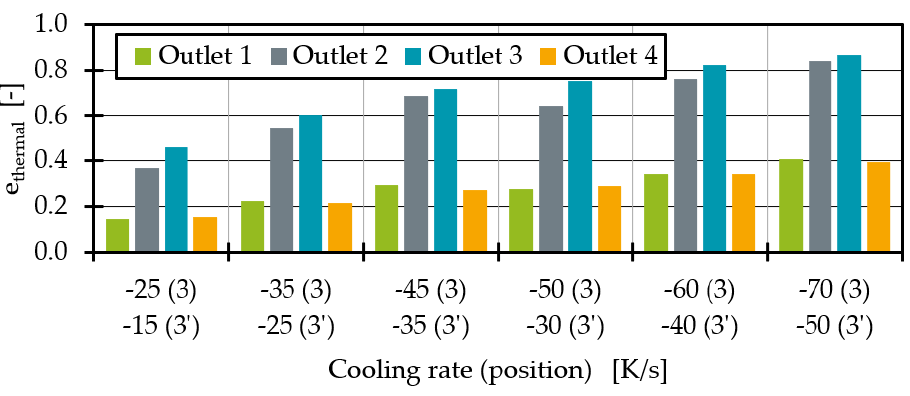
Figure 18. Thermal homogenisation indicator for two heat pipes with different performances at position 3 and 3 ′ .